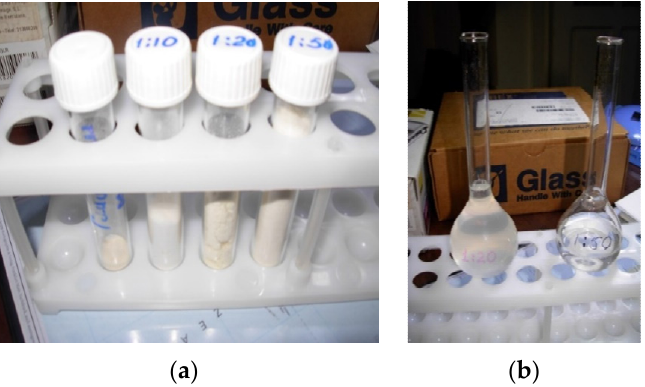
Figure 2. Photographs of supramolecular assemblies of bioactive glass with MSGA: ( a ) in powder form, from the right to the left samples MSGA:BG 50:1; MSGA:BG 20:1; MSGA:BG 10:1 and the leftmost is MSGA; ( b ) in gel form, from the left to the right samples MSGA:BG 20:1 and MSGA:BG 50:1.